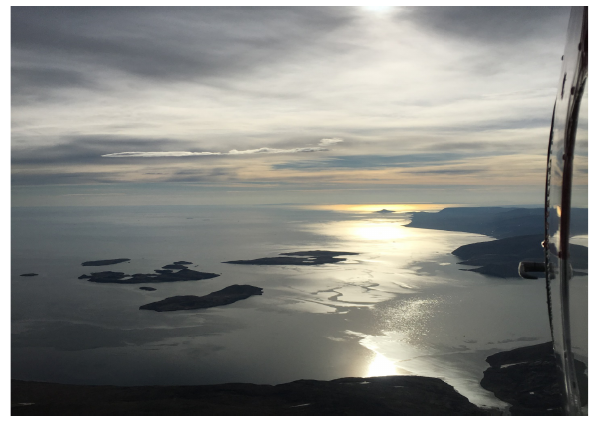
Figure 7. Why the work (and view) can feel like a religious experience. (Photo: R. G. Hansen). I'M NOT RELIGIOUS, BUT… Daniel G. Pike